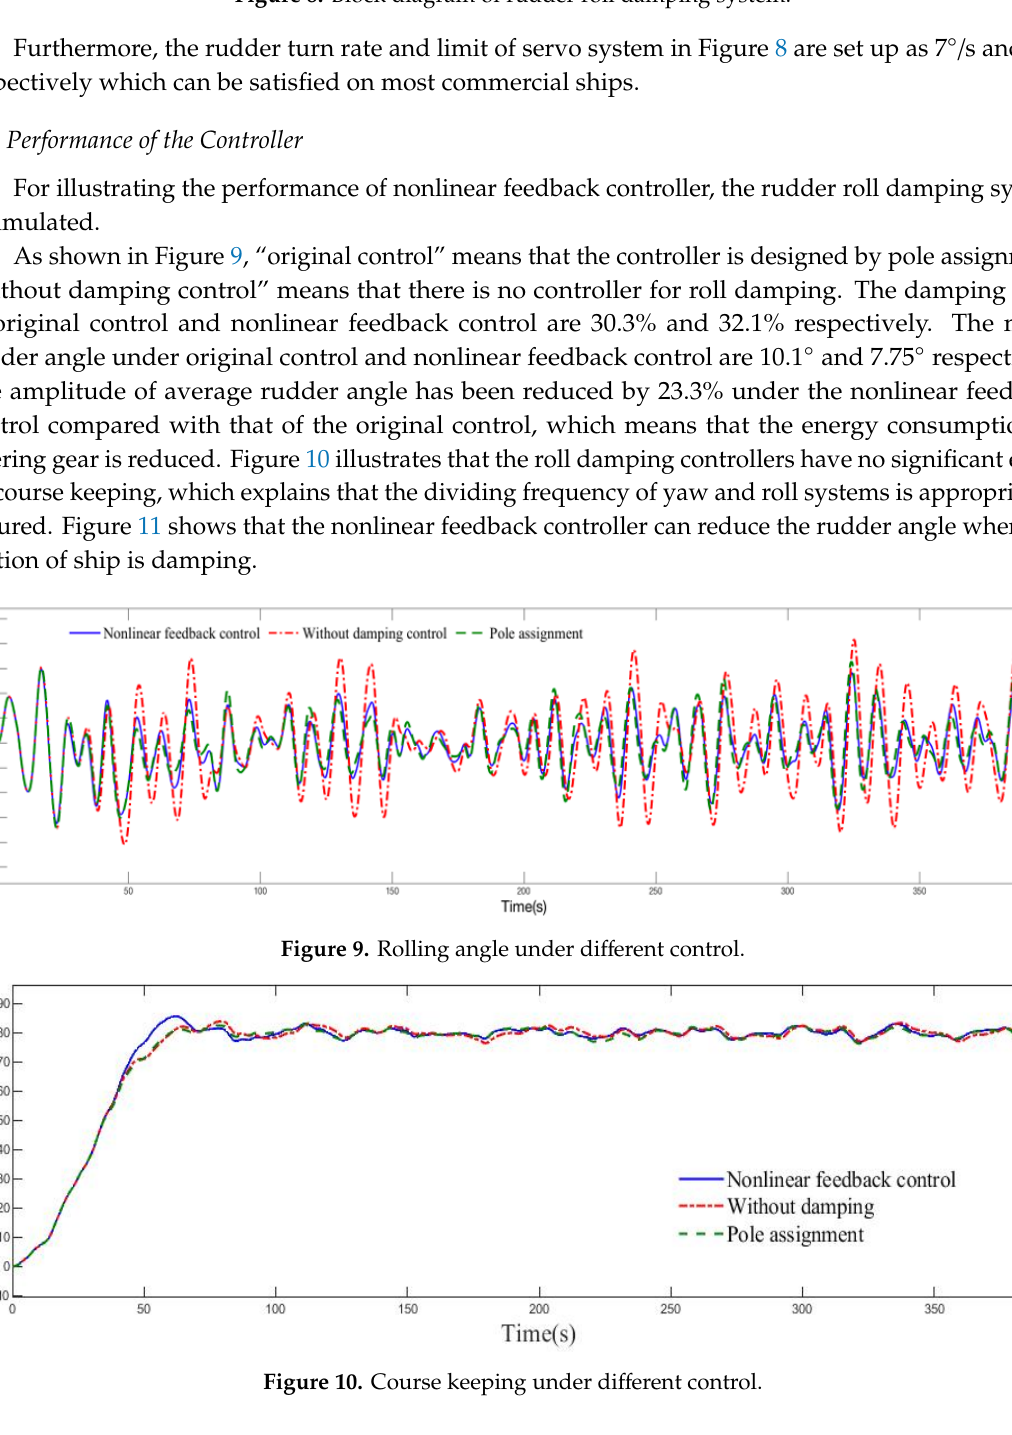
Figure 11. Rudder angle under different control. 4.2. Effect of Hold Time of ZOH on System In this part, the controller remains unchanged, while the hold times of the ZOH component are taken as 0.3 s, 0.5 s, 1 s, 1.5 s, 2 s separately to analyze the effect of hold time of the ZOH component to roll damping. As shown in Figure 12, poor performance of steering gear is caused by overlong hold time of ZOH. ZOH will hold the rudder angle for a period of time (T). It could reduce the steering frequency. With the increase of hold time of ZOH, the steer frequency decreases gradually, while the damping ratio is also decreasing. Figure 13 shows that the effect of roll motion damping of the controller is worse when the hold time of ZOH is larger. However, as shown in Figure 14, the performance of course keeping is still acceptable when the hold time of ZOH is taken as 2 s, which proves that steer frequency for course keeping can be lowered greatly. For more specific analysis, Table 2 gives the data of the experiments as aforementioned. ( a )